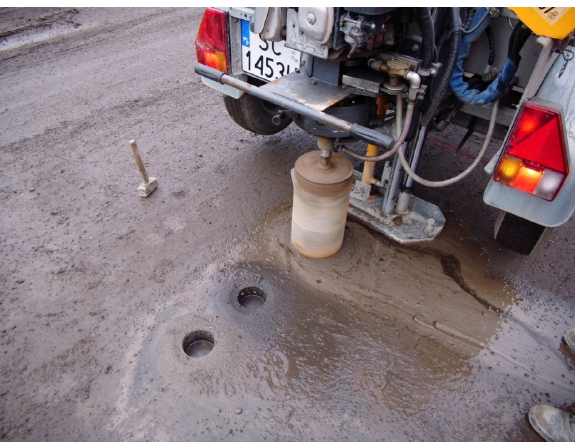
Figure 7. The drilling of the samples from the tested trial road pavement (AM-100%).